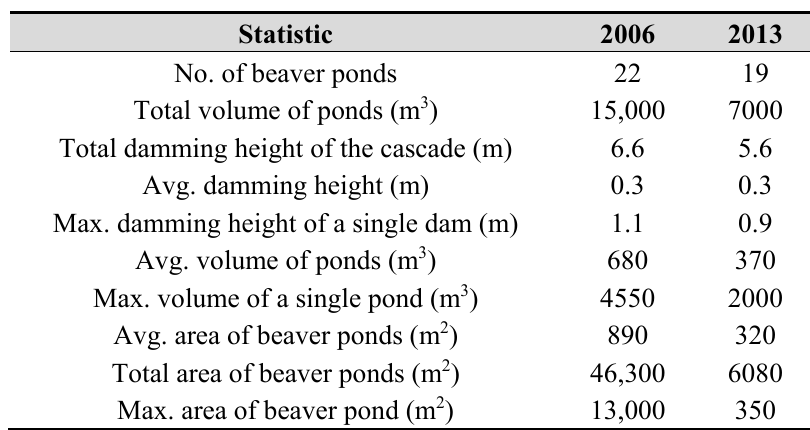
Table 1. Comparison of selected statistics of beaver ponds in Krzemianka river valley in 2006 and 2013.